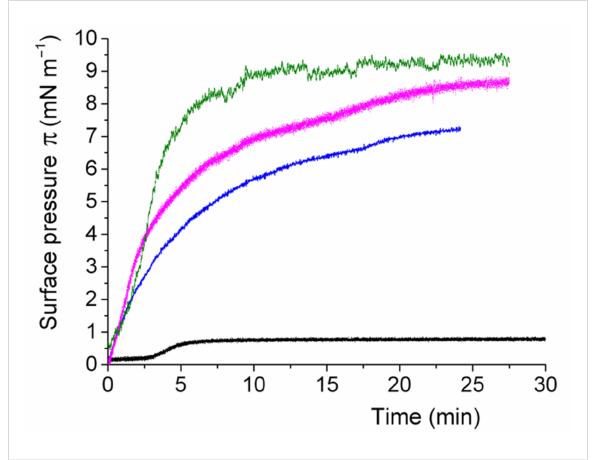
Figure 1: Adsorption kinetics of perfluoroalkylated lipopeptides 1 – 3 and the hydrocarbon analog 4 at the air/water interface (25 °C). Varia- tion of surface pressure π as a function of time for 1 (blue), 2 (magenta), 3 (green), and 4